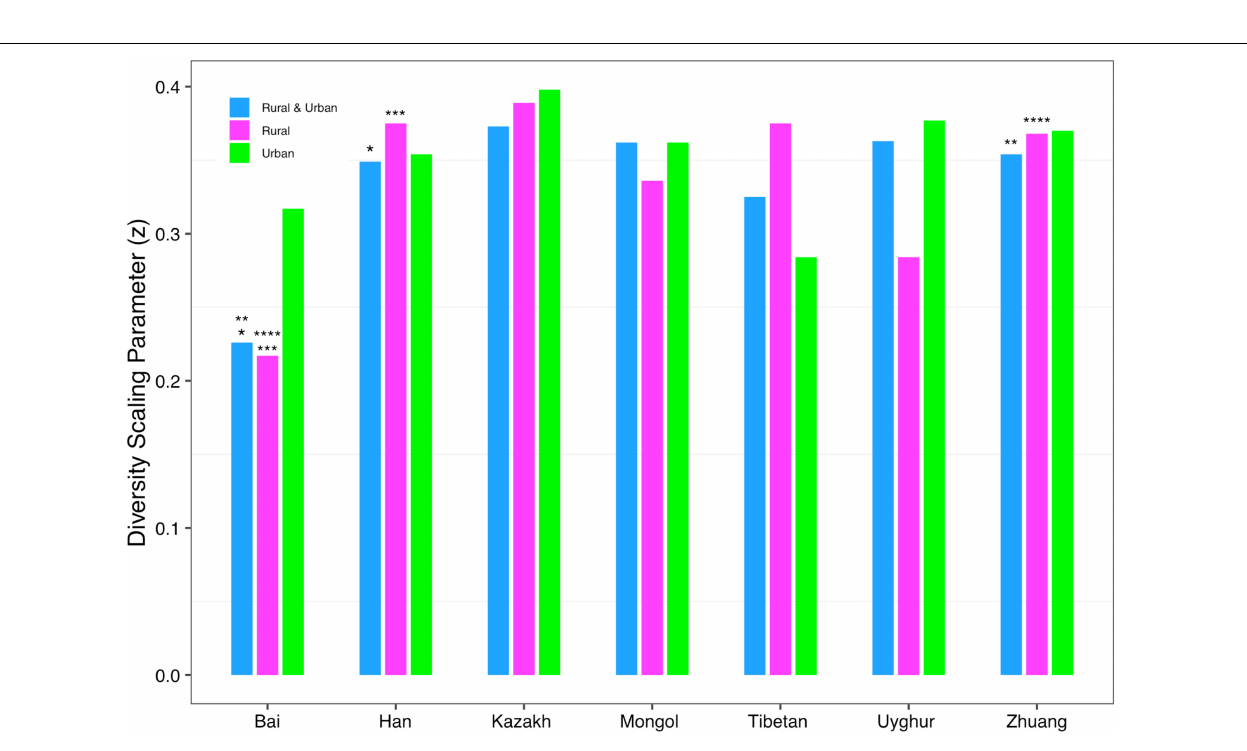
Frontiers in Microbiology |